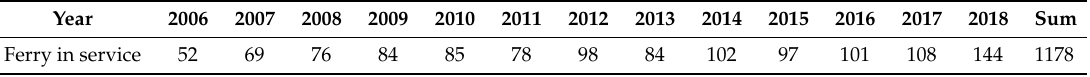
Table 13. Number of inland waterways ferries in service vs. year.